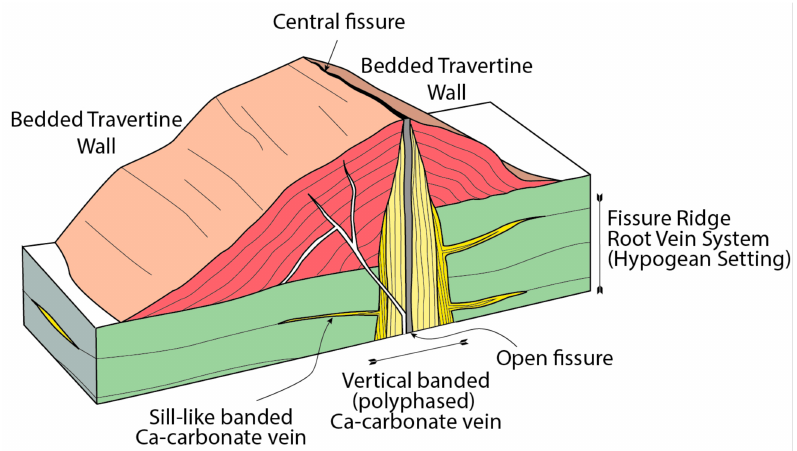
Figure 1. Diagram showing the anatomy of a fissure-ridge-type travertine